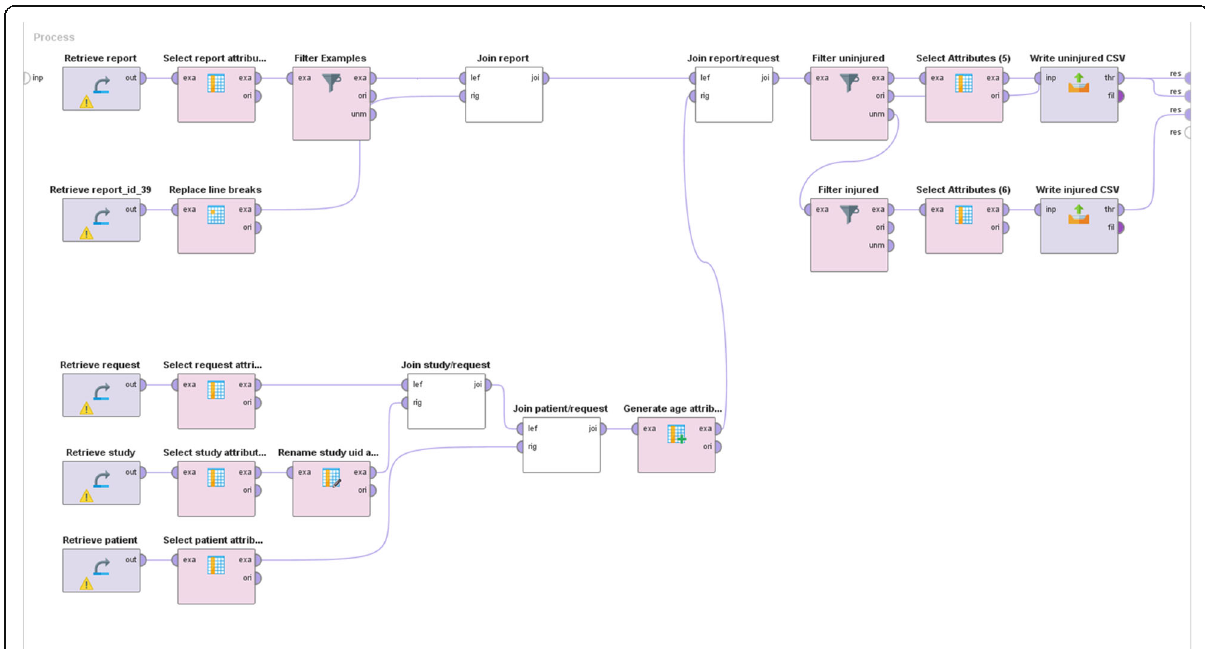
Fig. 3 Graphical representation of the access to the report database. Various tables need to be retrieved and combined. Finally, two lists of cases with and without fractures are written and saved as CSV